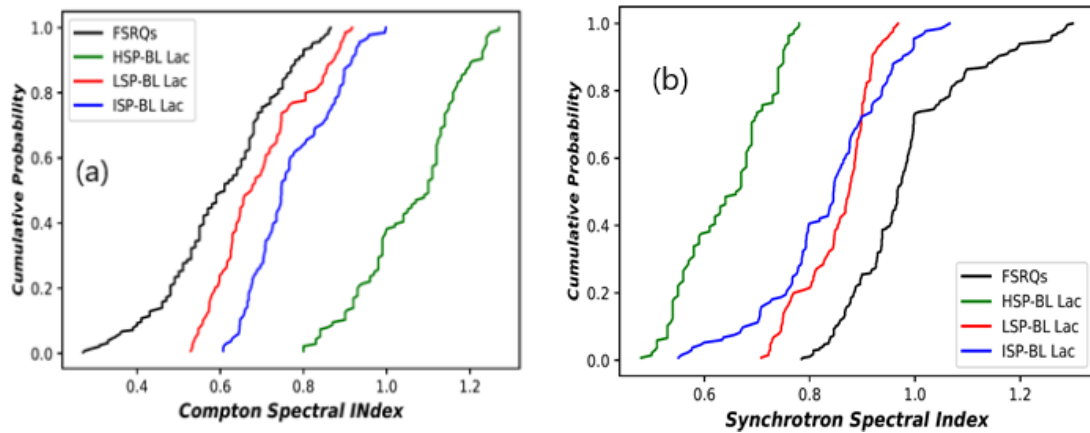
Figure 3. Cumulative Distributions of (a) Synchrotron (b) Compton spectral indices for FSRQs and BL